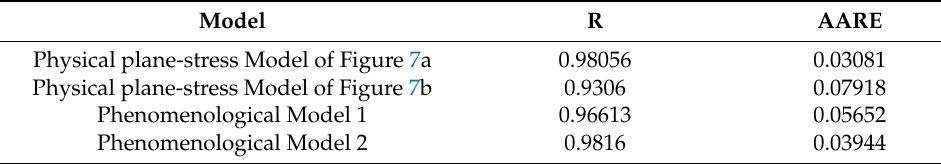
Table 7. The calculated AASE and